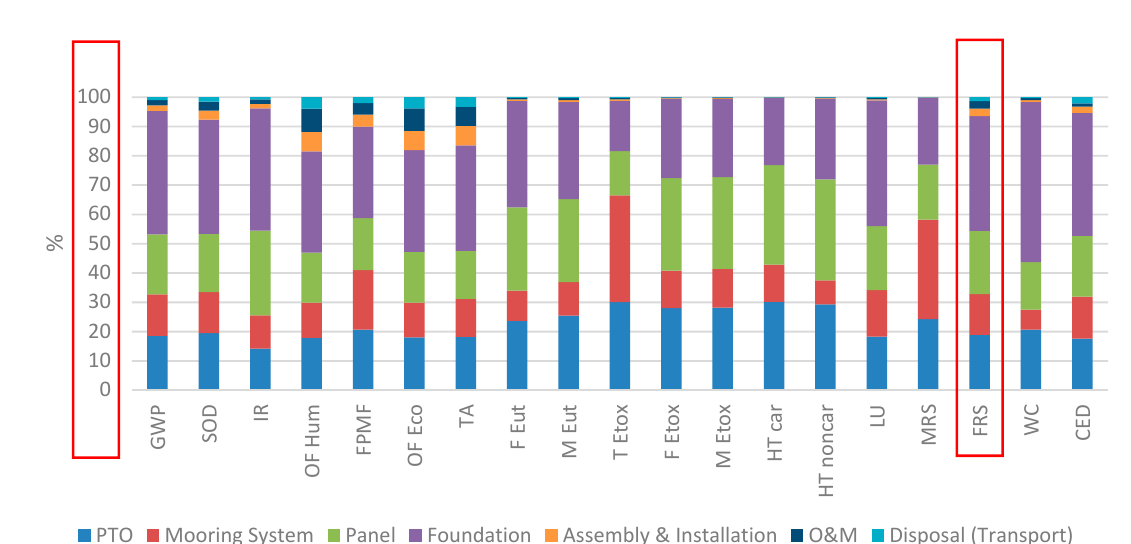
Figure 6. Breakdown of impacts by life cycle stage for each impact category including Cumulative Energy Demand (CED) (relative contribution).